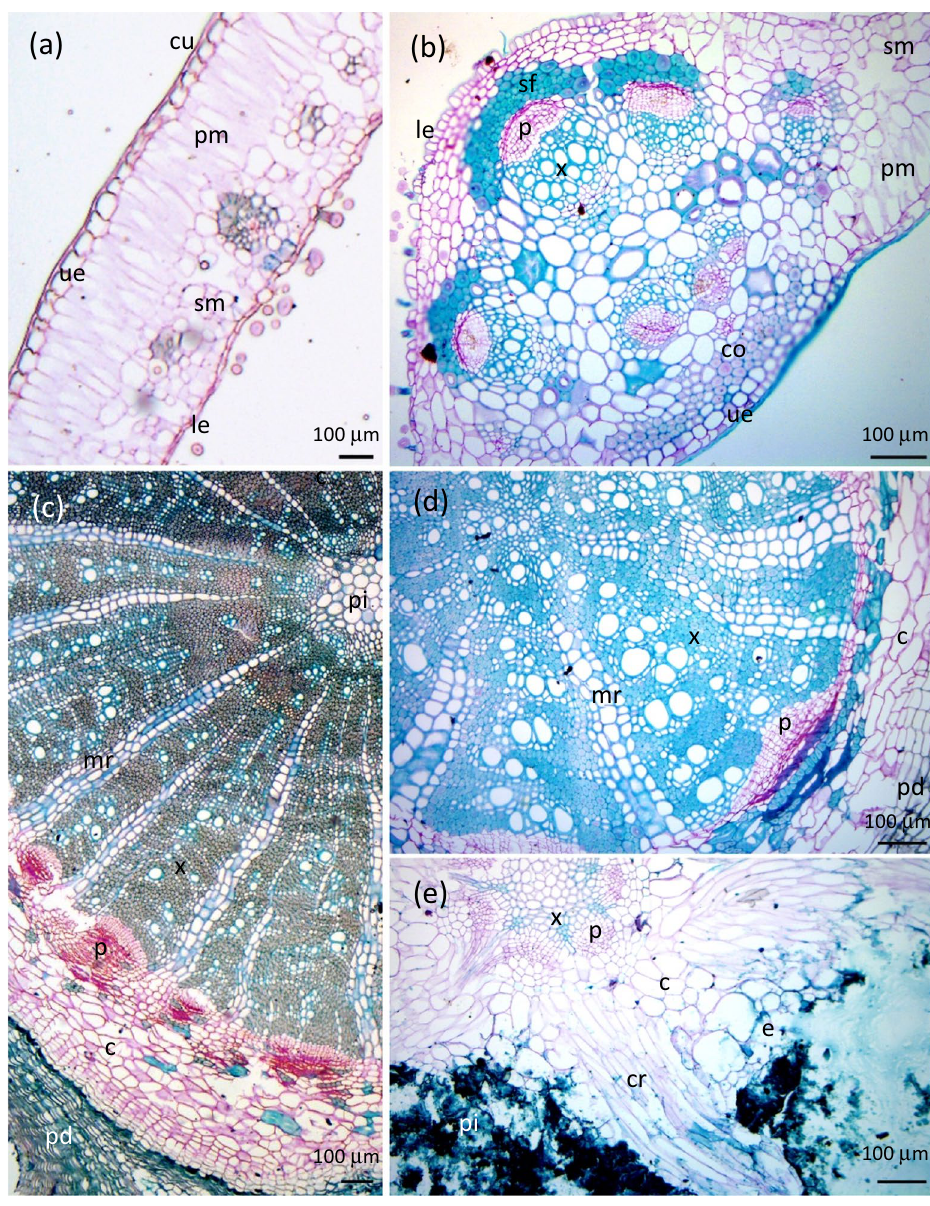
Figure 2. Light microscopy images of Grevillea meisneri anatomical structures. ( a ) Margin of a leaf; ( b ) mid- rib of a leaf; ( c ) stem; ( d ) primary root; ( e ) secondary root surrounded by the rootlets of a cluster. c cortex, co collenchyma, cr cluster rootlet, cu cuticle, e epidermis, le lower epidermis, mr medullary ray, p phloem, pi pith, pm palisade mesophyll, pd periderm, sf sclerenchyma fiber, sm spongy mesophyll, ue upper epidermis, x